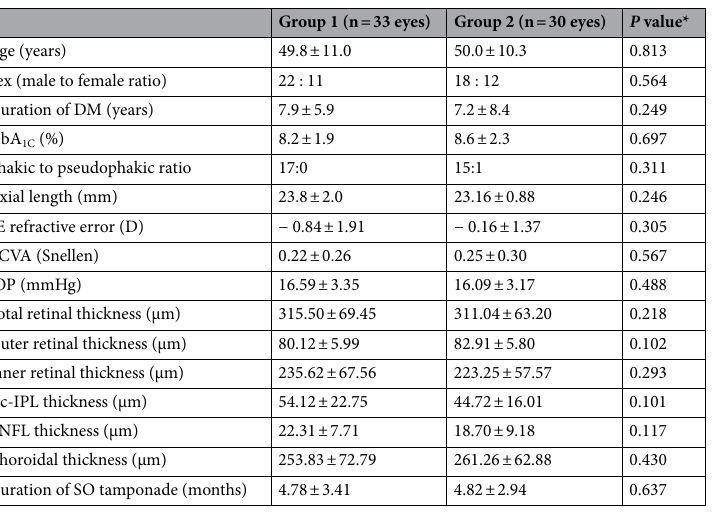
Table 1. The baseline clinical characteristics and retinal layer measurements in different groups according to timing of ILM peeling. The data are presented as the mean ± standard deviation. Group 1, ILM peeling during SO injection surgery. Group 2, ILM peeling during SO removal surgery. The retinal layer thickness was measured in a 1-mm central macular area. * P < 0.05 was considered statistically significant, unpaired t -test. BCVA best-corrected visual acuity, DM diabetes mellitus, Gc-IPL ganglion cell-inner plexiform layer, ILM internal limiting membrane, IOP intraocular pressure, RNFL retinal nerve fiber layer, SE spherical equivalent, SO silicone